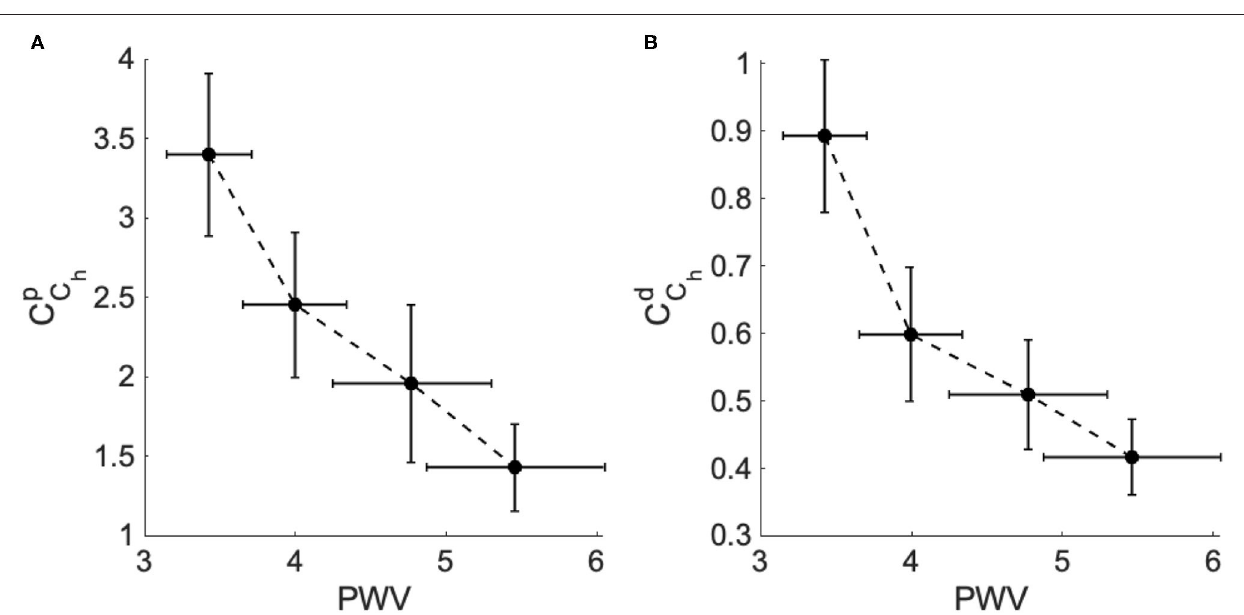
FIGURE 5 | The fractional-order compliance evaluated at the heart pulsation. (A) Represents bar plot of the proximal ( C p C for the in-human hypertensive subjects of dataset 1. (B) Represents error bars plot of the proximal ( C p C hypertensive groups of dataset 2. Each bar in this plot represent the mean value of the evaluated fractional-order compliances per group and the error corresponds to the standard error of the mean per group.